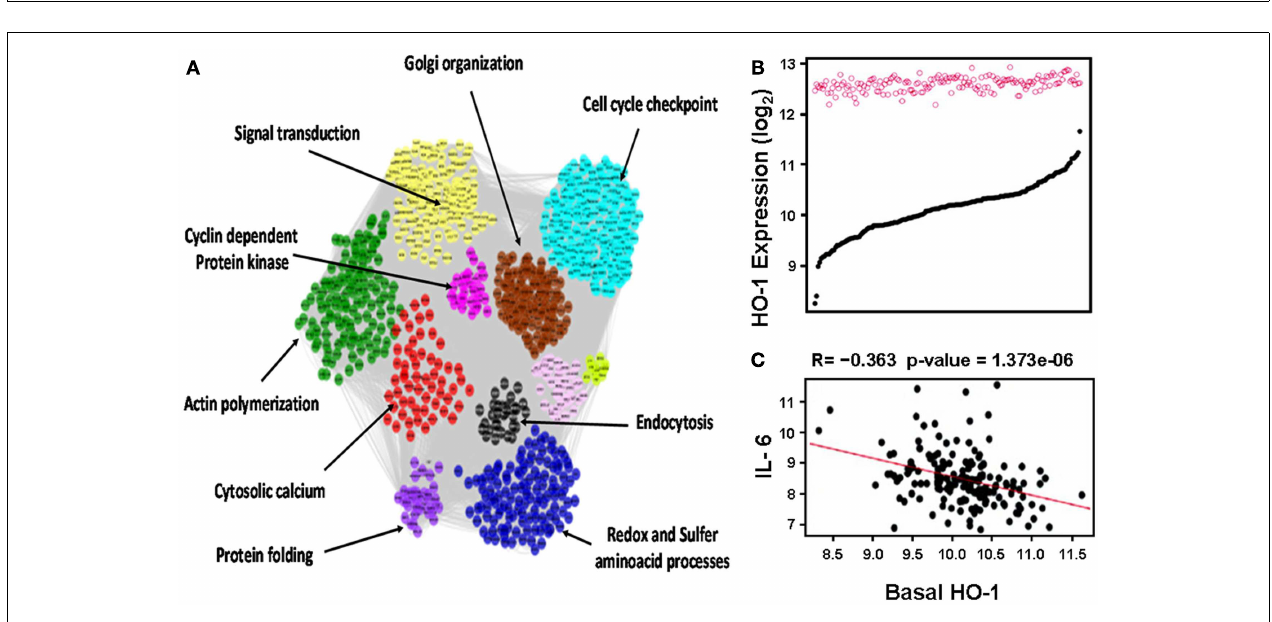
FIGURE 2 | Basal HO-1 protects against oxidation and inflammation. HO-1 + / − and HO + / + (WT) mice were subjected to partial liver warm ischemia for 90min followed by 6h of reperfusion.Two groups of mice were treated with CoPP. (A) Basal HO-1 mRNA levels, (B) Post-ischemia reperfusion (IR) HO-1 mRNA levels, (C) Basal HO-1